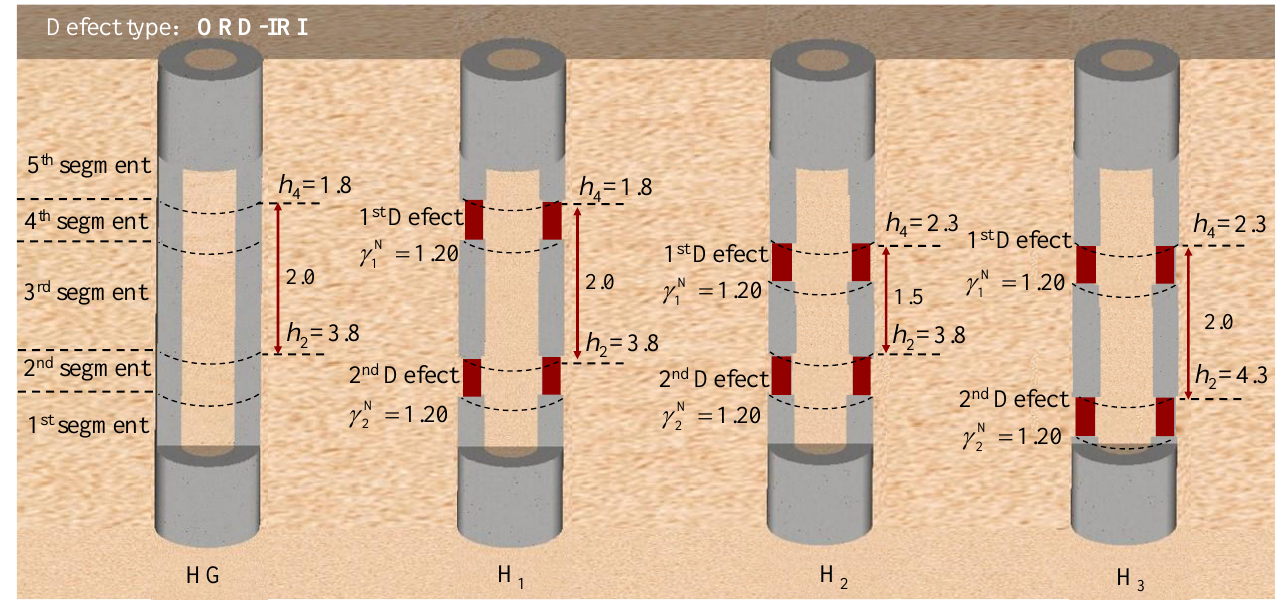
Figure 11. Diagram of necking defect with different depths.